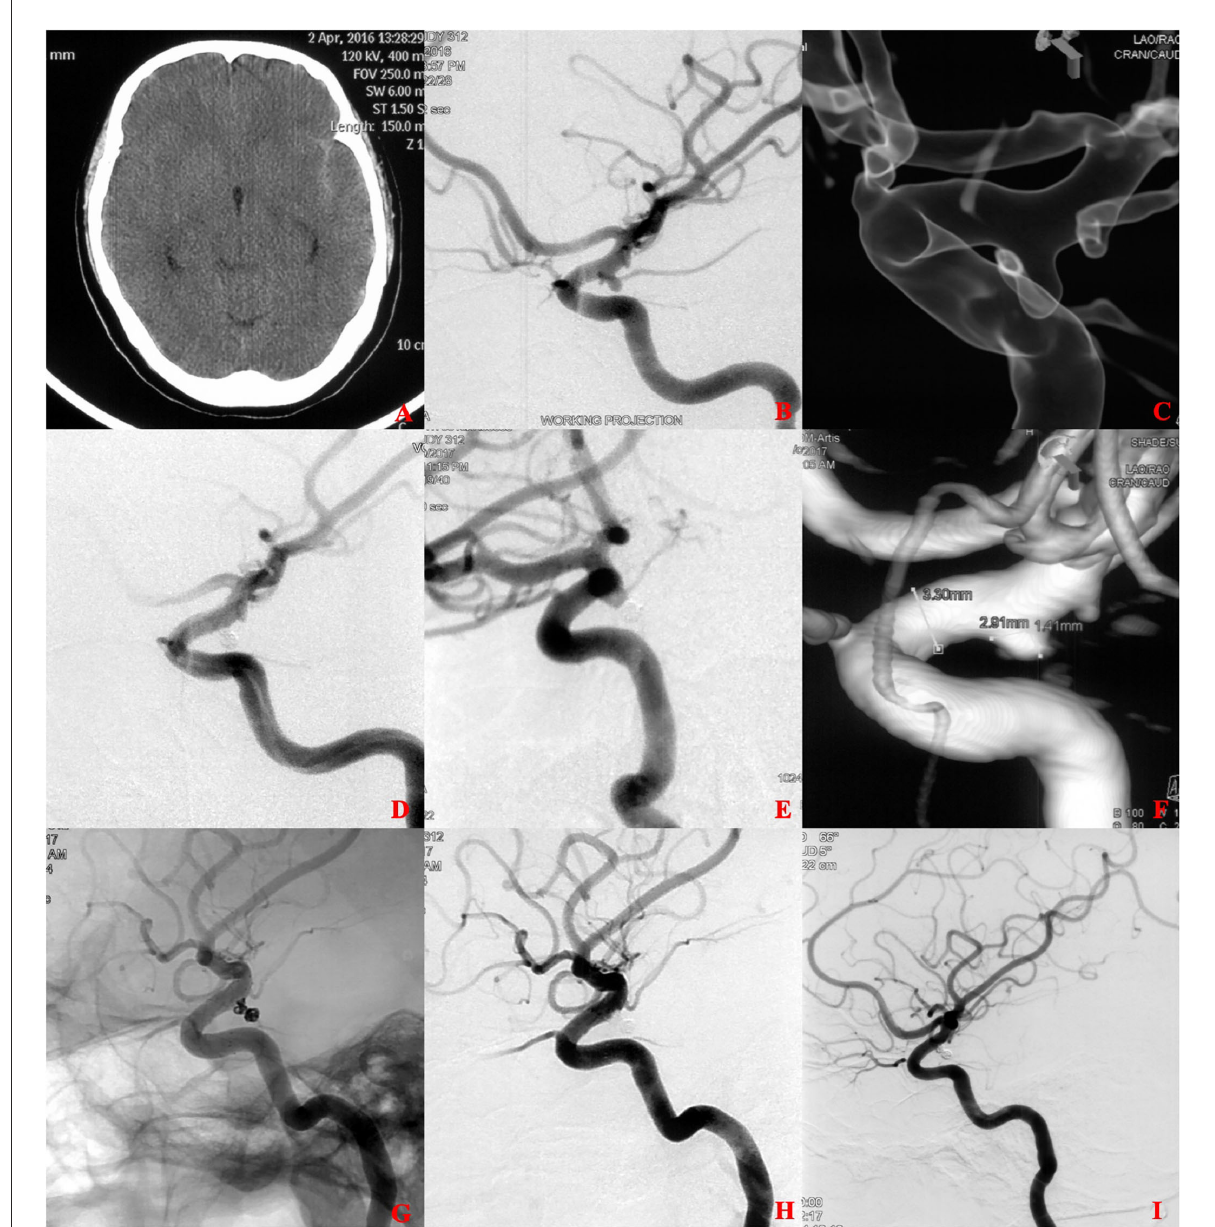
FIGURE2 A ruptured tiny posterior communicating artery (PCOM) aneurysm treated with coiling alone (CA). (A) The patient was admitted with spontaneous subarachnoid hemorrhage. (B,C) Cerebral angiography and 3D reconstruction revealed a tiny PCOM aneurysm. (D) The aneurysm was treated with coiling embolization only. Immediate angiography showed that the aneurysm was completely occluded. (E,F) 6 months later, angiographic images showed postoperative recurrence of the aneurysm. (G,H) The aneurysm retreated with additional coiling embolization and an LVIS stent (4.5 × 15mm). Immediate angiography showed that the aneurysm was completely occluded. (I) 12 months later, angiographic images showed complete occlusion of the aneurysm.